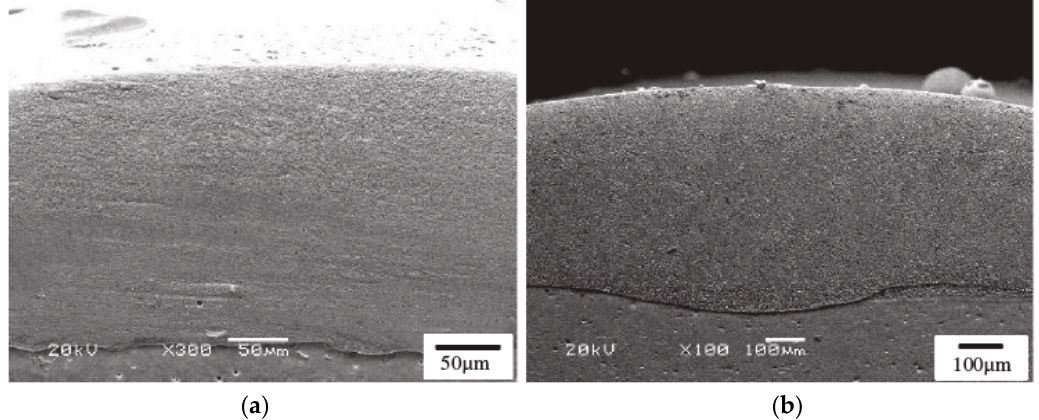
Figure 5. Cross-sectional morphology of laser cladding Ni-based alloy/nano-Ni encapsulated h-BN self-lubricating composite coating: ( a ) the Neodymium-doped Yttrium Aluminium Garnet (Nd: YAG) laser cladding; ( b ) the CO 2 laser cladding [42]. Reprinted with permission from [42]; 2017 Elsevier.